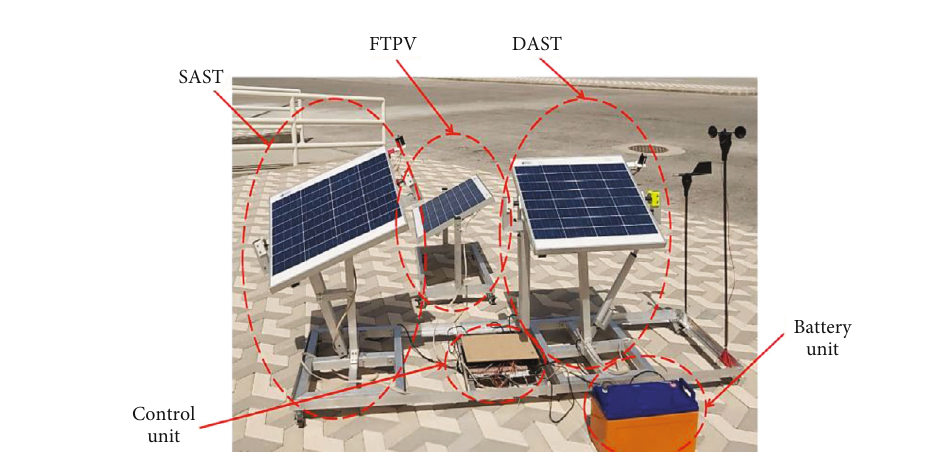
Figure 6: System ’ s PID response.